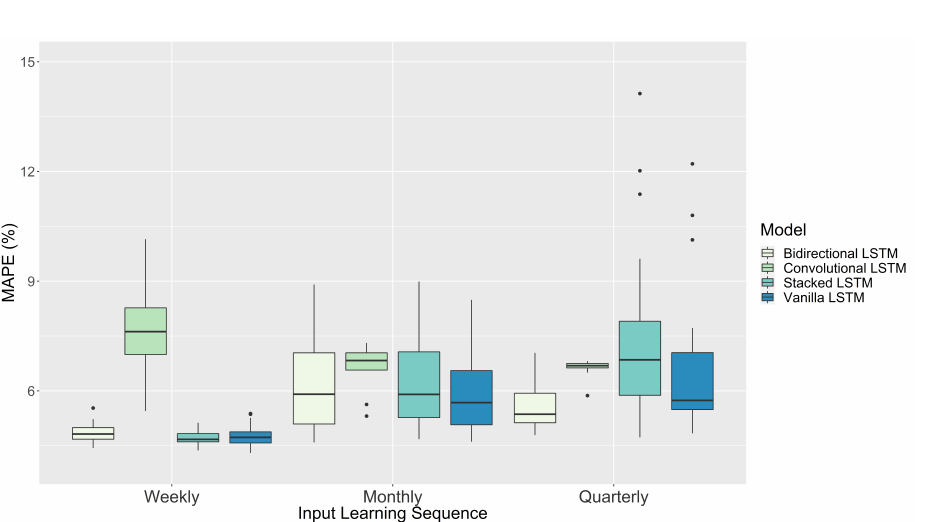
Figure 9. Boxplot of recorded MAPE (%) by model and input learning sequence, implemented through different hyperparameter